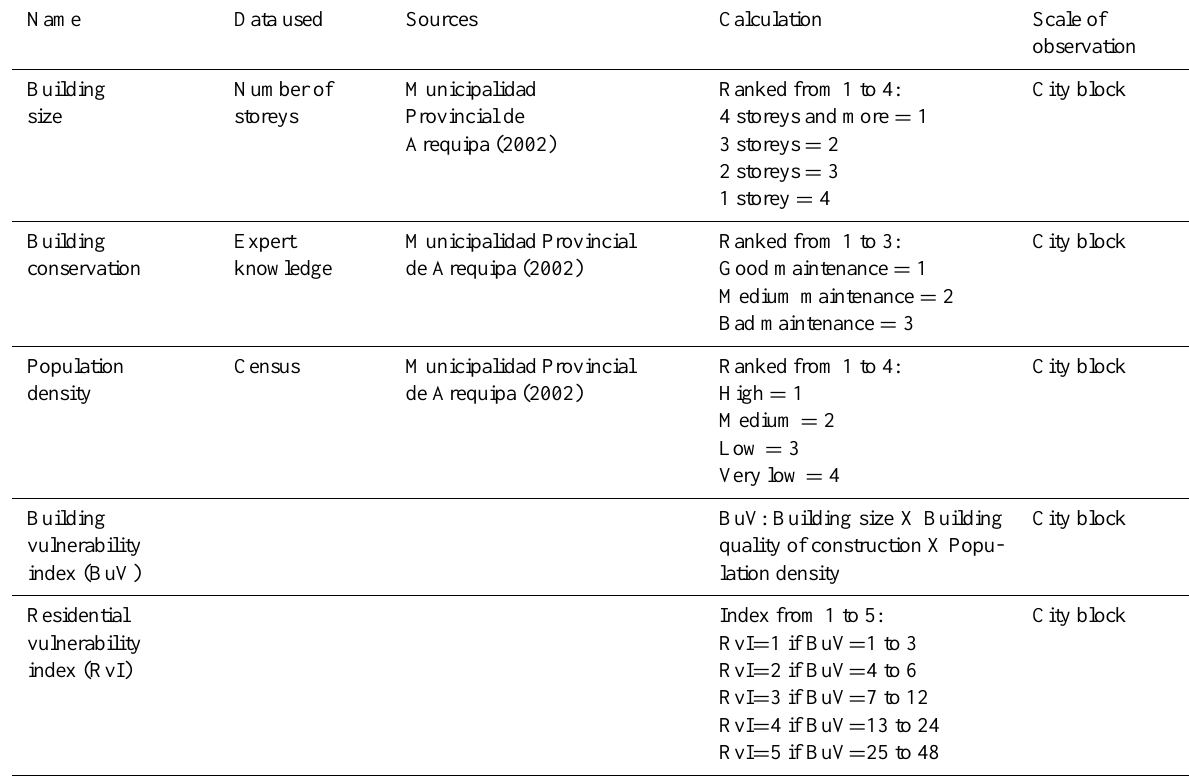
Table 4. Evaluating building vulnerability. Building vulnerability (BuV) is defined as a multiplicative function of the size, the quality of con- struction of buildings and the population density. Data stems from the official urban-planning scheme of Arequipa (Municipalidad Provincial de Arequipa, 2002). The data precision is at the city-block scale. To obtain a discrete indicator, five classes of residential vulnerability (RvI) were created. Classes take into account how skewed distributions can be generated by multiplication. The map of building vulnerability for the whole city of Arequipa is shown in Fig. 8.